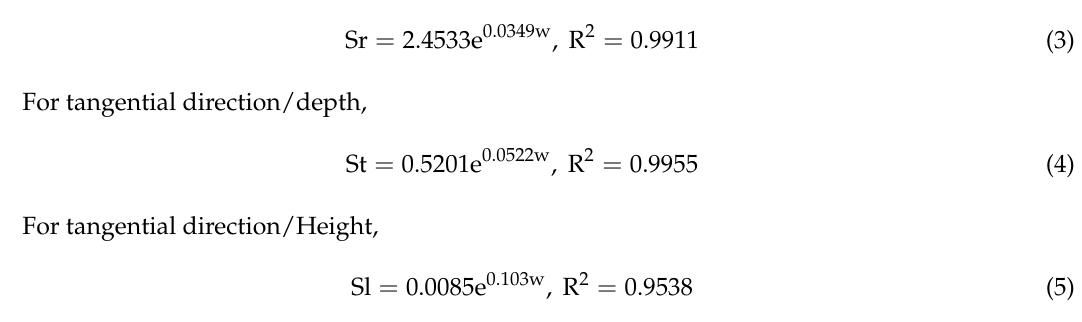
Table 2. Physical property changes of untreated and treated woods at each treatment temperature.